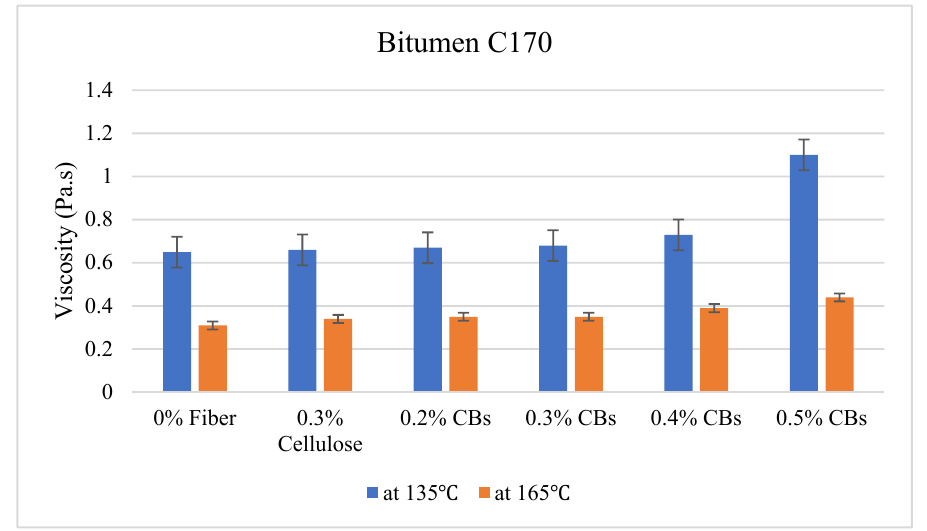
Figure 12. Comparative viscosity of Bitumen C170 modified with different types of fiber.